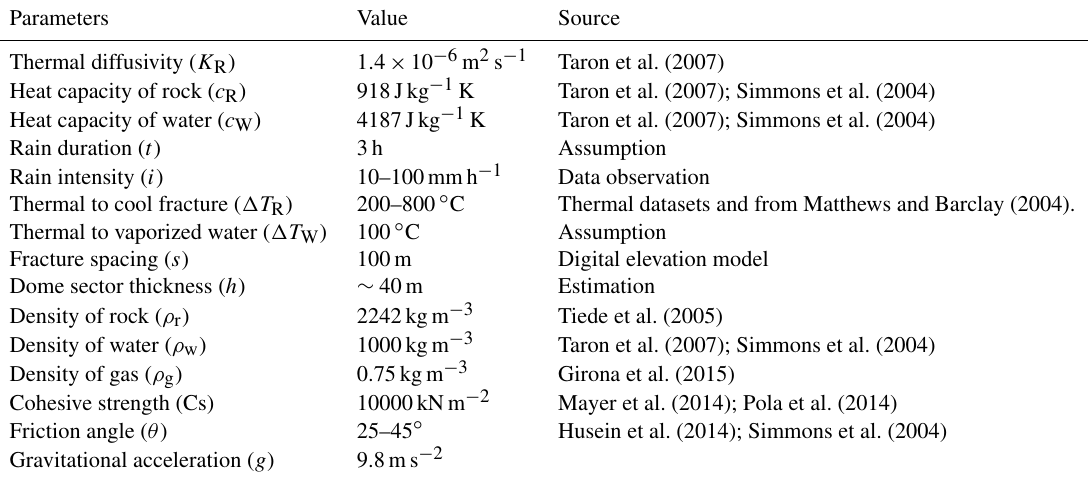
Table 1. Detail parameters to calculate depth water percolation (Eq. 1) and factor of safety (Eq. 2) Parameters Value Source Thermal diffusivity ( K R ) Taron et al. (2007) Heat capacity of rock ( c R ) 918Jkg − 1 K Taron et al. (2007); Simmons et al. (2004) Heat capacity of water ( c W ) 4187Jkg − 1 K Taron et al. (2007); Simmons et al. (2004) Rain duration ( t ) 3h Assumption Rain intensity ( i ) 10–100mmh − 1 Data observation Thermal to cool fracture ( (cid:49)T R ) 200–800 ◦ C Thermal datasets and from Matthews and Barclay (2004). Thermal to vaporized water ( (cid:49)T W ) 100 ◦ C Assumption Fracture spacing ( s ) 100m Digital elevation model Dome sector thickness ( h ) ∼ 40m Estimation Density of rock ( ρ r ) 2242kgm − 3 Tiede et al. (2005) Density of water ( ρ w ) 1000kgm − 3 Taron et al. (2007); Simmons et al. (2004) Density of gas ( ρ g ) 0.75kgm − 3 Girona et al. (2015) Cohesive strength (Cs) 10000kNm − 2 Mayer et al. (2014); Pola et al. (2014) Friction angle ( θ ) 25–45 ◦ Husein et al. (2014); Simmons et al. (2004) Gravitational acceleration ( g ) 9.8ms −